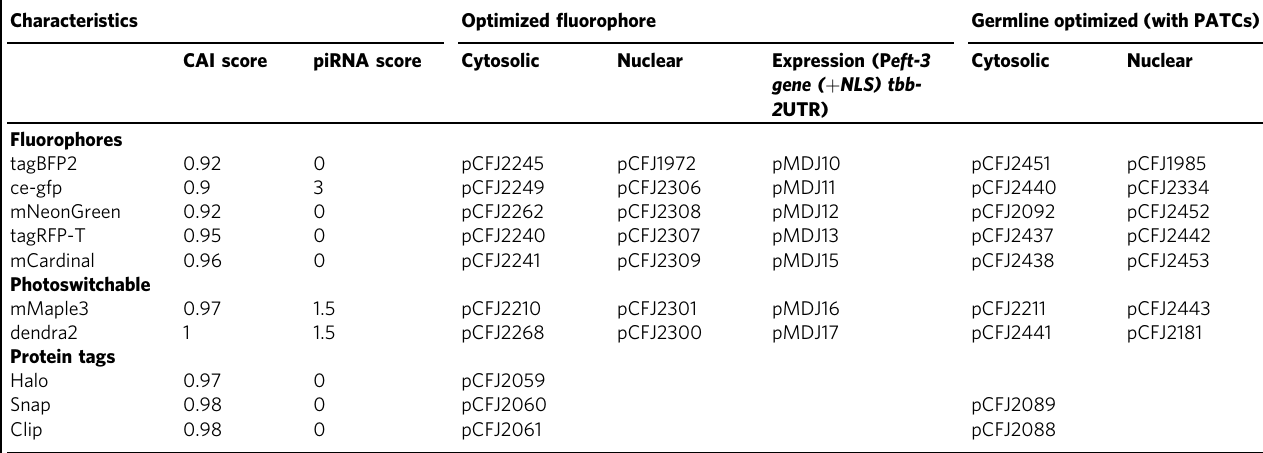
Table 2 Optimized fl uorescent proteins and tags.